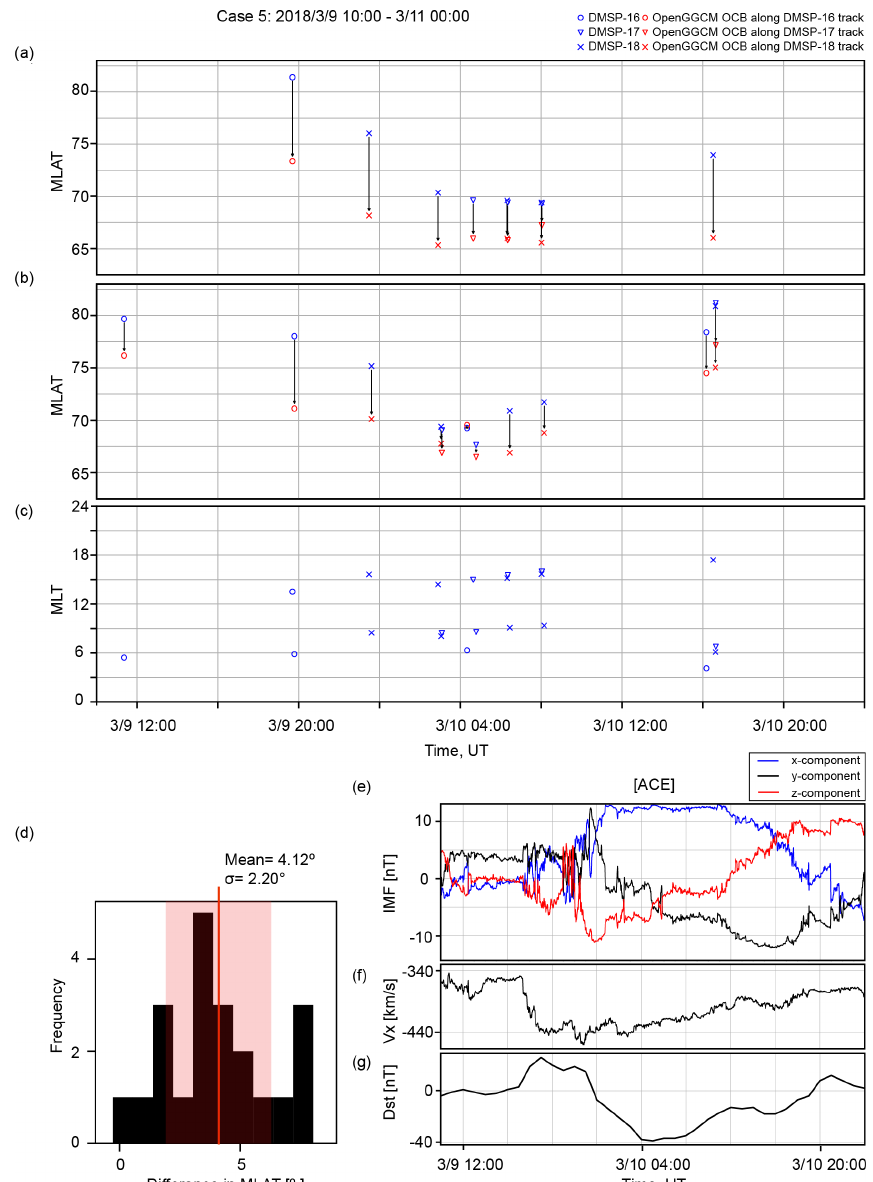
Figure 5. Comparison between the observed and simulated OCB latitudes for 10 March 2018 event in the same format as Fig. 1.